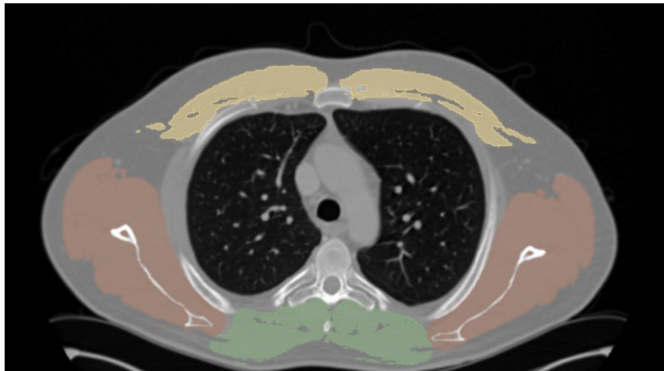
Figure 1. Morphometric measurements cross-sectional total paraspinal area (TPA, green), total rotator-cuff area (TRA, red), and total pectoral area (TPeA, yellow). Total muscle area (TMA) was defined as the sum of the former three measurements segmented on axial cross-sectional plane at the level of the fifth thoracic vertebra. Both transverse processes are visible in this plane.